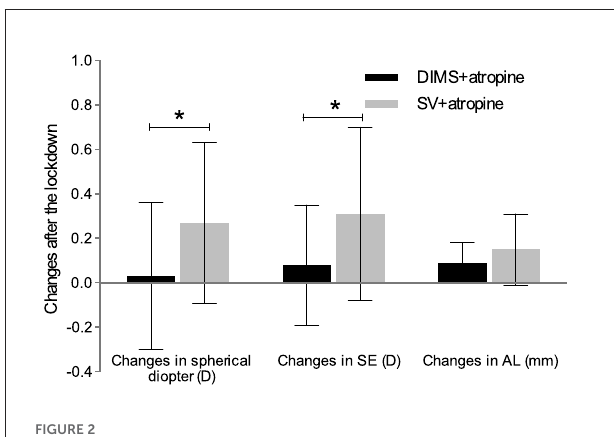
FIGURE2 Changes of spherical diopter, SE and AL in DIMS + atropine and SV + atropine group after the 2022-lockdown in Shanghai. *Significant difference between the two groups. SE, spherical equivalent; AL, axial length; DIMS, defocus incorporated multiple segments lenses; SV, single vision spectacle